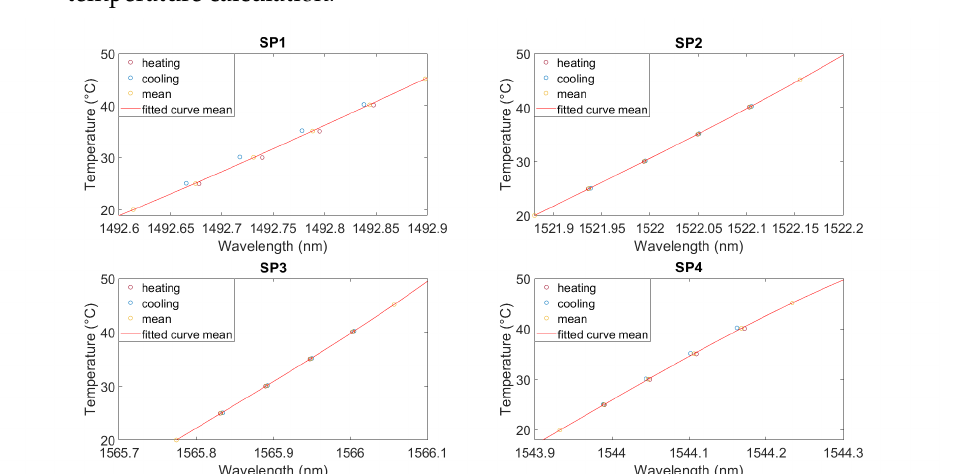
Figure 4. Calibration curve in air for FBG3 from each sensor. SP1: optical fiber in PEEK capillary, single-point mounting; SP2: optical fiber in fused silica tube with polyimide coating, single-point mounting; SP3: optical fiber in fused silica tube, removed polyimide coating, single-point mounting; SP4: optical fiber in fused silica tube, removed polyimide coating, double-point